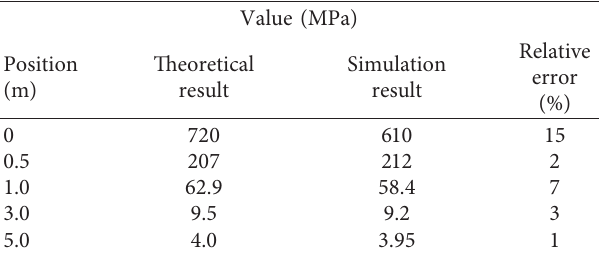
Table 5: Comparison of the theoretical calculation and numerical simulation results.